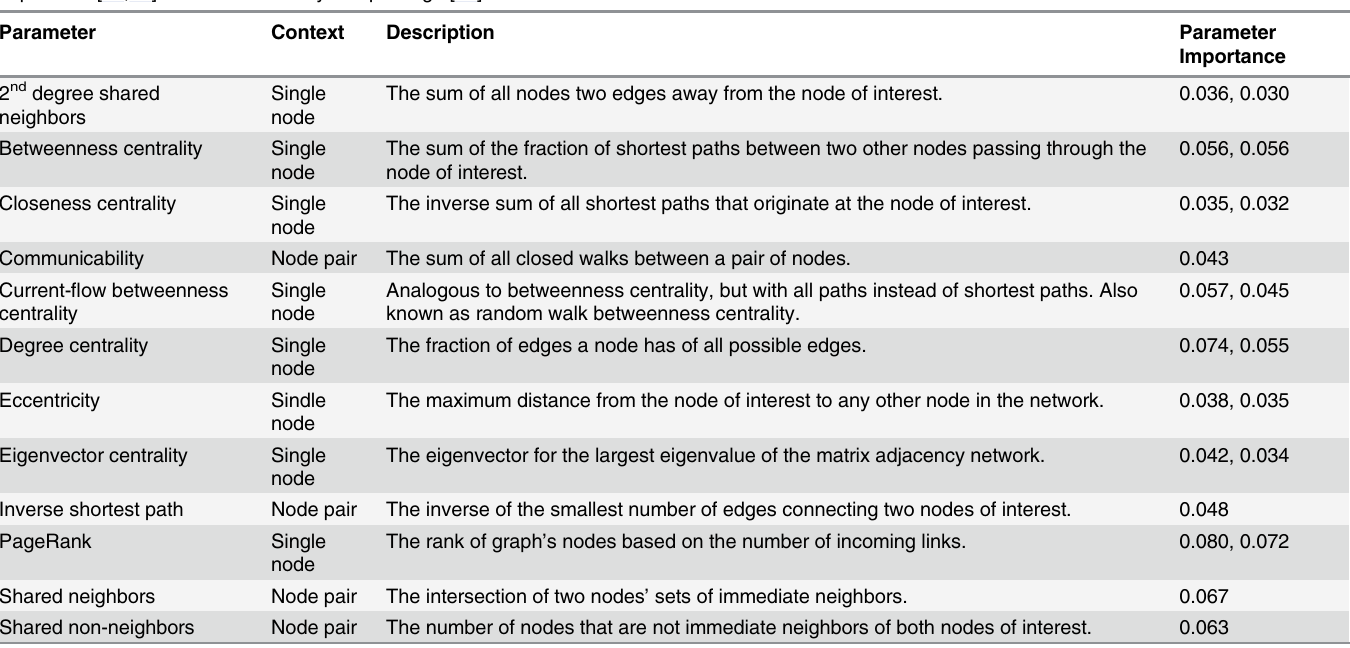
Table 1. Network parameters used in our model. A single-node network parameter provides two values to the feature vector per pair (8 single-node parameters create 16 values per pair). Each node-pair parameter contributes one value describing that pair. Parameter importance is measured using Gini importance[17,18] in the NetworkX Python package.[19]